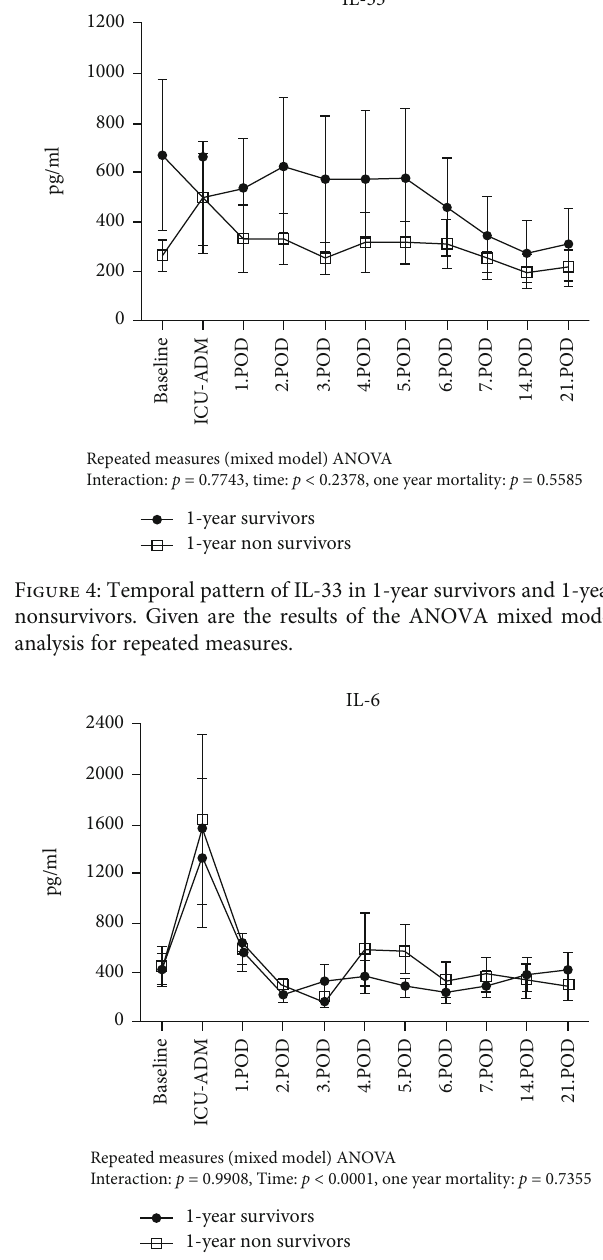
Figure 5: Temporal pattern of IL-6 levels in 1-year survivors and 1- year nonsurvivors. Given are the results of the ANOVA mixed model analysis for repeated